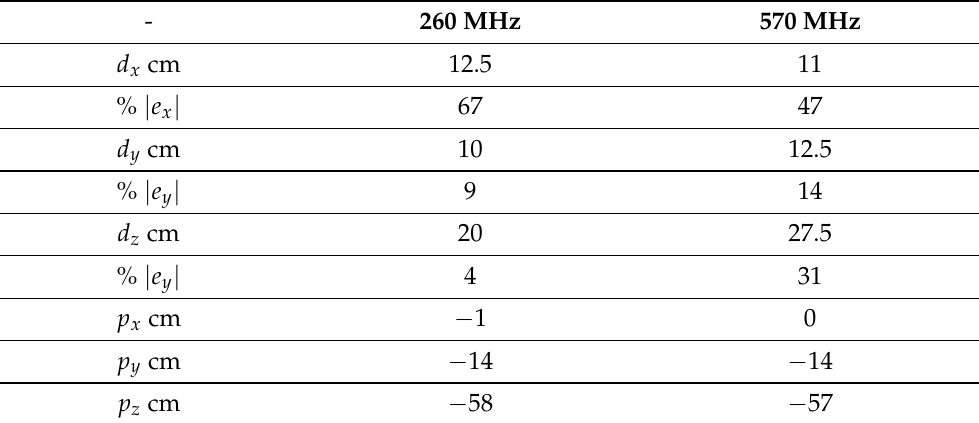
Table 2. FLA Results Target Metrics. Target’s size ( d ), absolute size errors | e | , and position ( p ), obtained by imaging with FLAs while target is close to antenna 11.